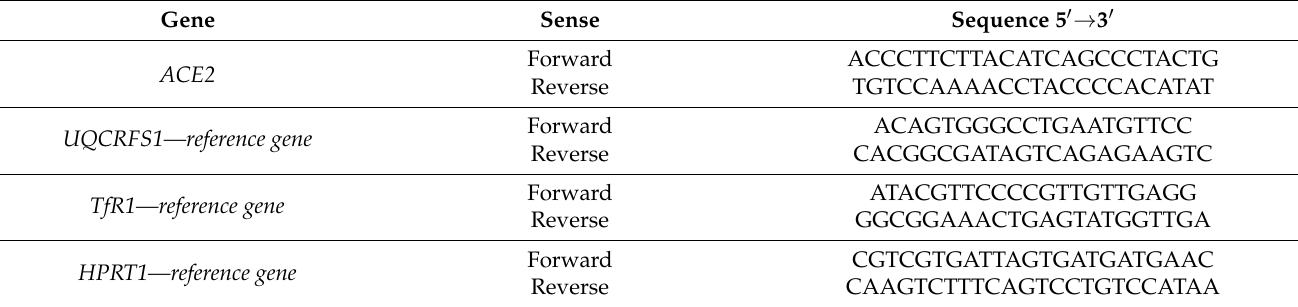
Table 1. Oligonucleotide sequences used in quantitative